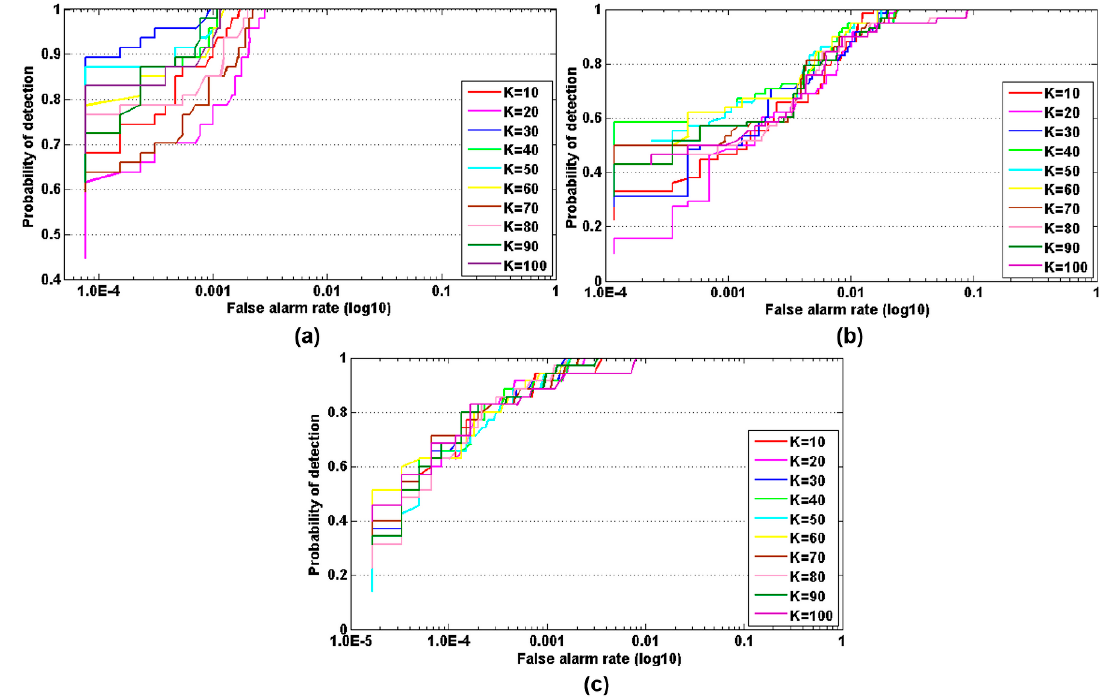
Figure 14. The logarithmic receiver operating characteristic (ROC) curves of RSLAD with different choices of projection dimensions K on the three datasets: ( a ) PaviaC; ( b ) San Diego; and ( c ) Botswana.